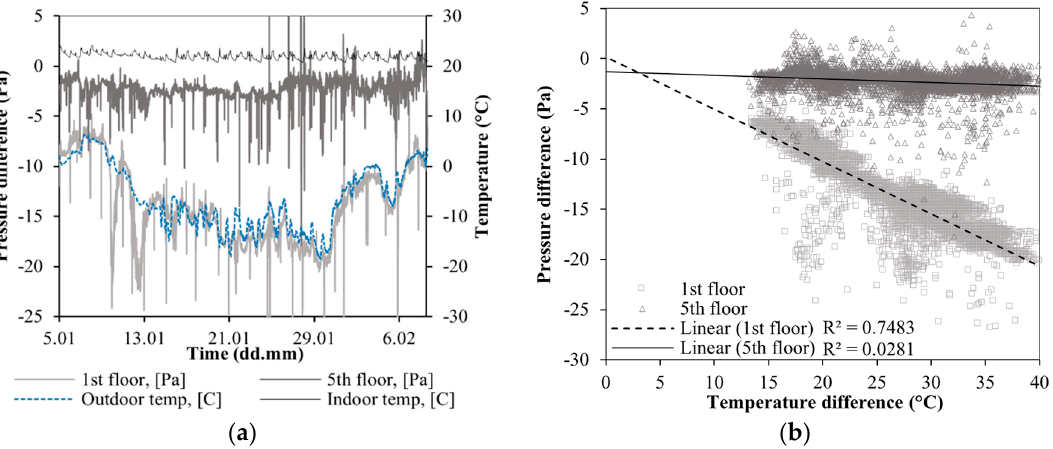
Figure 8. ( a ) The measured indoor and outdoor pressure di ff erences in the first and fifth floor apartments, indoor and outdoor temperature in the heating season during a one-month period; ( b ) The dependence of pressure conditions on the indoor–outdoor temperature difference.